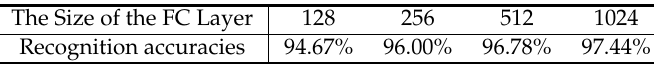
Table 6. Recognition accuracies vs. Size of the FC